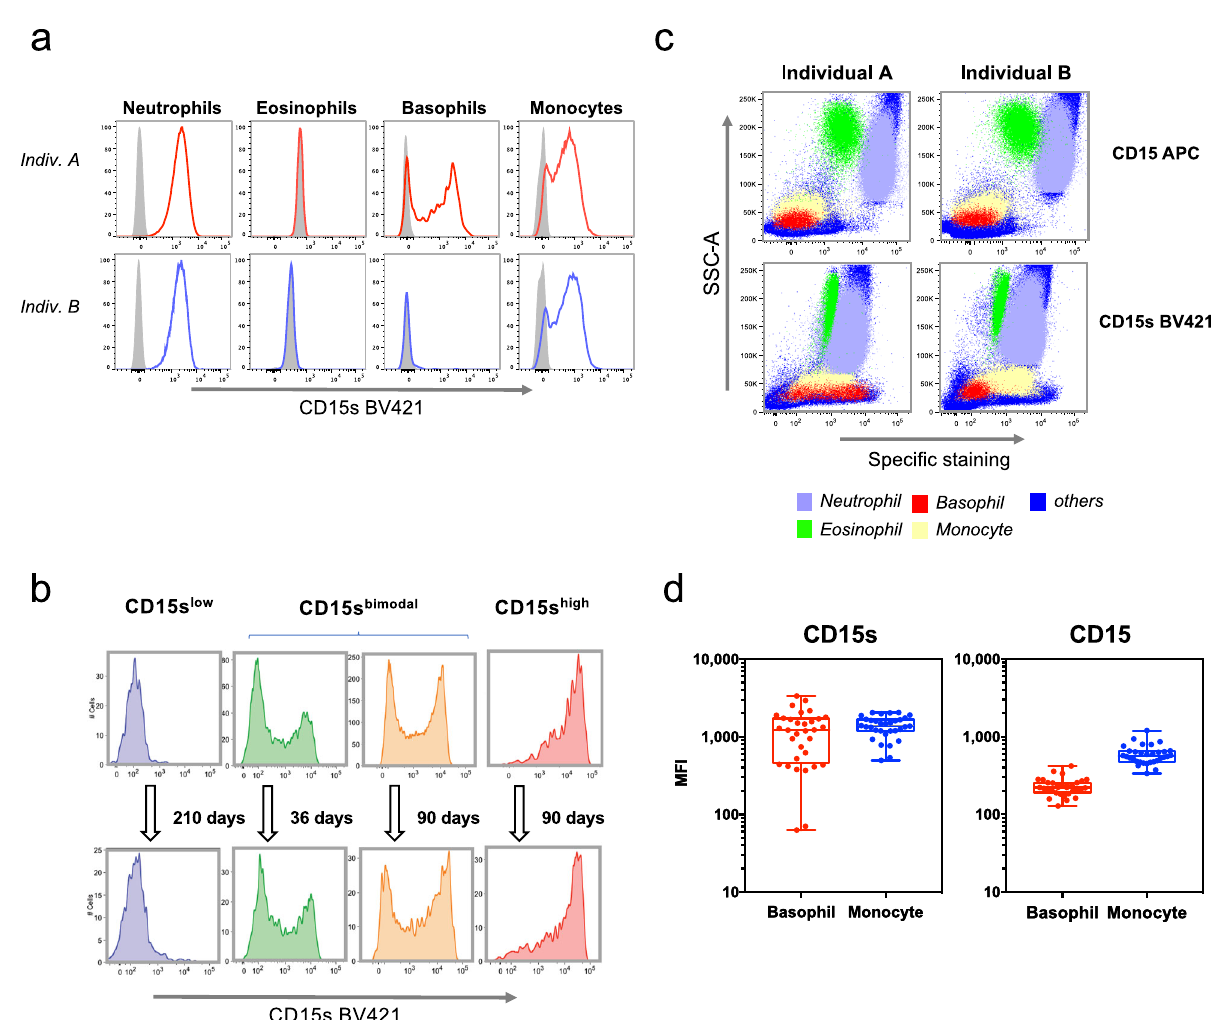
Fig. 1 CD15s (sLe x ) expression on human basophils. a CD15s staining. FACS analysis of whole-blood samples of two individuals differing in the CD15s expression on their basophils. CD15s staining is shown for neutrophils, eosinophils, basophils, and monocytes. Gray peaks represent the background staining based on “ fl uorescence minus one ” (FMO). b Temporal stability of the CD15s pattern. The CD15s staining on basophils is shown for four individuals with either low (CD15s low ), bimodal (CD15s bimodal ), or high CD15s expression on basophils (CD15s high ). Two examples of bimodal expression are shown differing in the ratio between the CD15s low and the CD15s high peak. The FACS plots indicate CD15s measurement from four different individuals between two time points. c Comparison of CD15 and CD15s expression on various leukocytes. The dot plots represent FACS pro fi le of whole-blood samples of two individuals stained with anti-CD15 and anti-CD15s. The speci fi c staining is shown in reference to the side scatter (SSC-A); the location of neutrophils (violet), eosinophils (green), basophils (red), monocyte (yellow), and other cells (blue) is indicated. Cell populations were de fi ned by cell type- speci fi c gating (Supplementary Fig. 4). d Cohort-wide distribution of CD15s and CD15 expression. The boxplots indicate the mean fl uorescence intensity (MFI) of CD15s ( n = 32) and CD15 ( n = 29) on basophils and monocytes. Each dot represents one individual; all samples were obtained from healthy volunteers of the Singapore SSIC